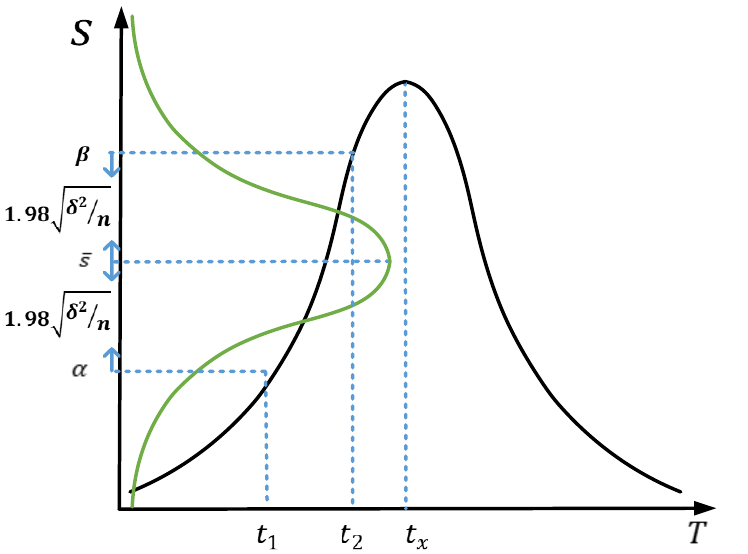
Figure 7. The black line represents the variation of similarity between the virtual frame and ideal frame with cumulative time; the green line is the confidence interval curve.